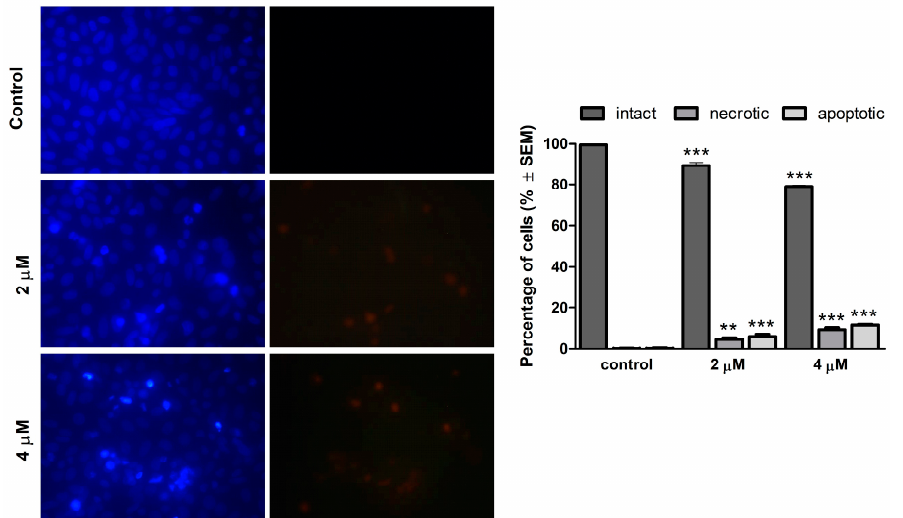
Figure 3. Morphological changes of SiHa cells after 24 h of exposure to 13AES3, visualized by HOPI double staining. A significant decrease in viable cells, as well as a remarkable increase in both necrotic and apoptotic cell populations, were induced by 13AES3. Left panel : representative fluorescent images (10 × magnification); right panel : percentages of viable, necrotic, and apoptotic cell populations. ** and *** indicate significance at p < 0.01 and p < 0.001, respectively.